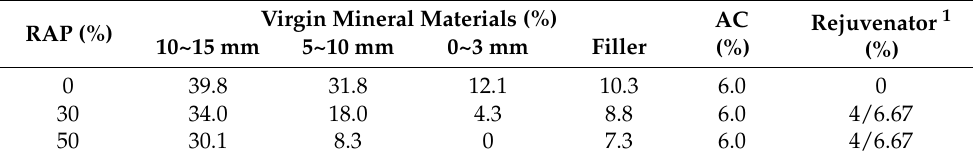
Table 4. Mix design results.